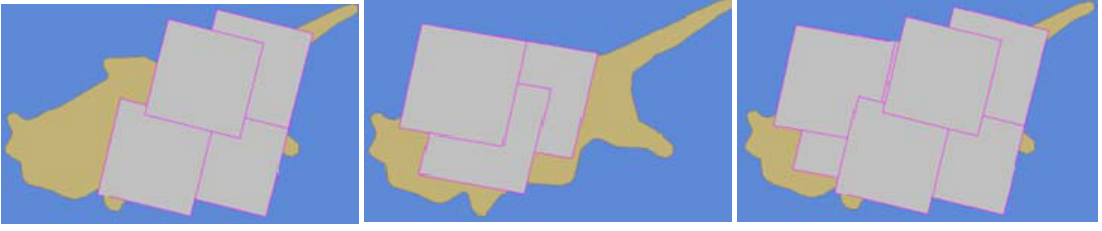
Figure 9. Inputdataset (Left:Spot5,Middle:ASTER,Left:Spot+ASTER)